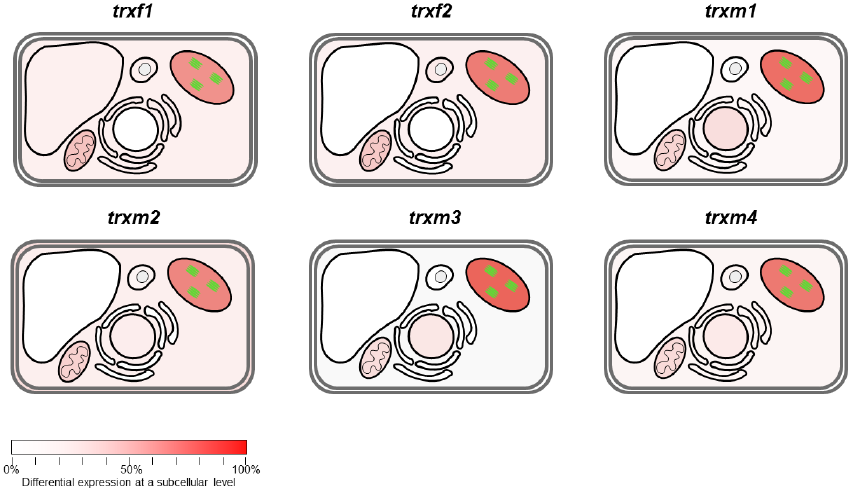
Figure 5. Differential expression shown at a sub-cellular level. The red color intensity is indicating if differential expressions are significant in a given organelle.